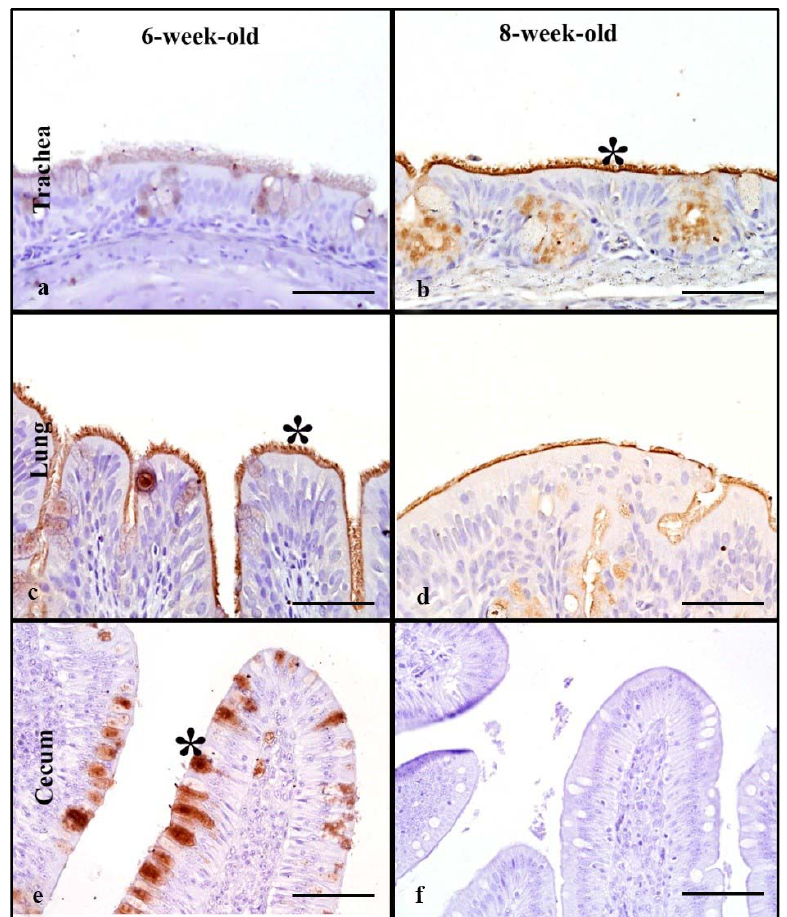
Figure 3. HPAIV H5 rHA binding in turkeys of different age groups, denoted by dark brown staining using DAB- HRP via protein histochemistry, denoted by asterisk (*). Very strong rHA binding to the trachea in the 8-week-old turkeys ( b ) compared to milder binding in the 6-week-old birds ( a ). Very strong rHA binding to the lung and cecum of 6-week-old turkeys is also evident ( c , e ). Scale bar is 50 µm.